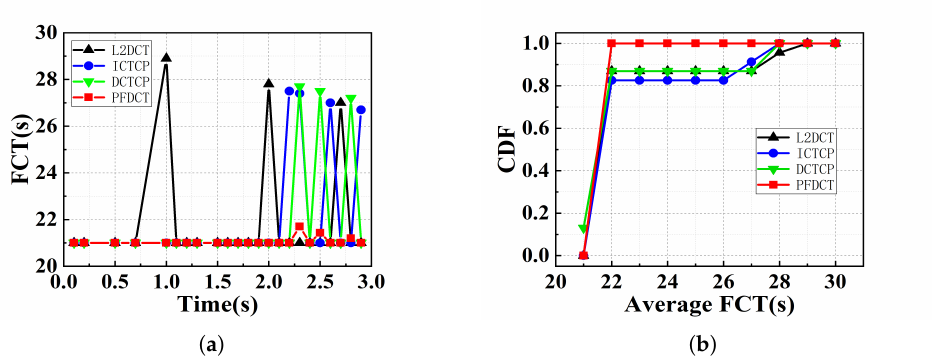
Figure 11. The average FCT comparison of multiple schemes in large-scale topology. ( a ) The average FCT comparison with varying time. ( b ) The CDF of average FCT.